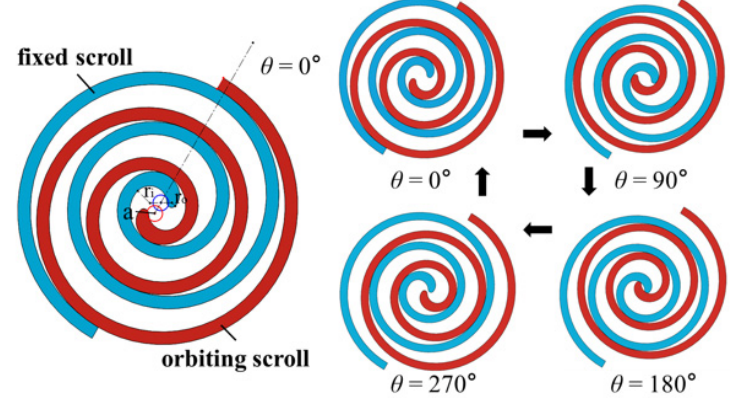
Figure 1. Operating cycle of scroll compressors.